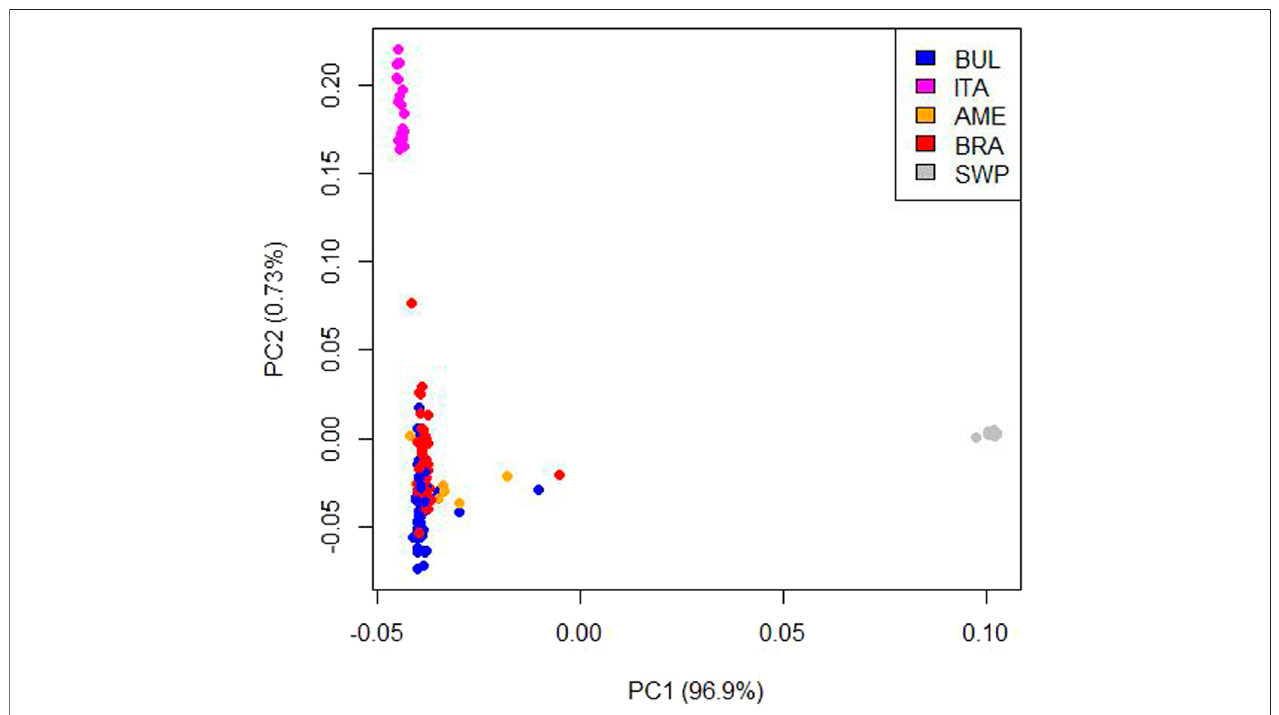
FIGURE 1 | PCA plot generated based on the genomic relationship matrix of the fi ve buffalo populations ( n (cid:1) 250). BUL, Bulgarian Murrah; BRA, Brazilian Murrah; ITA, Italian Mediterranean; AME, American Murrah; SWP, Philippine swamp.